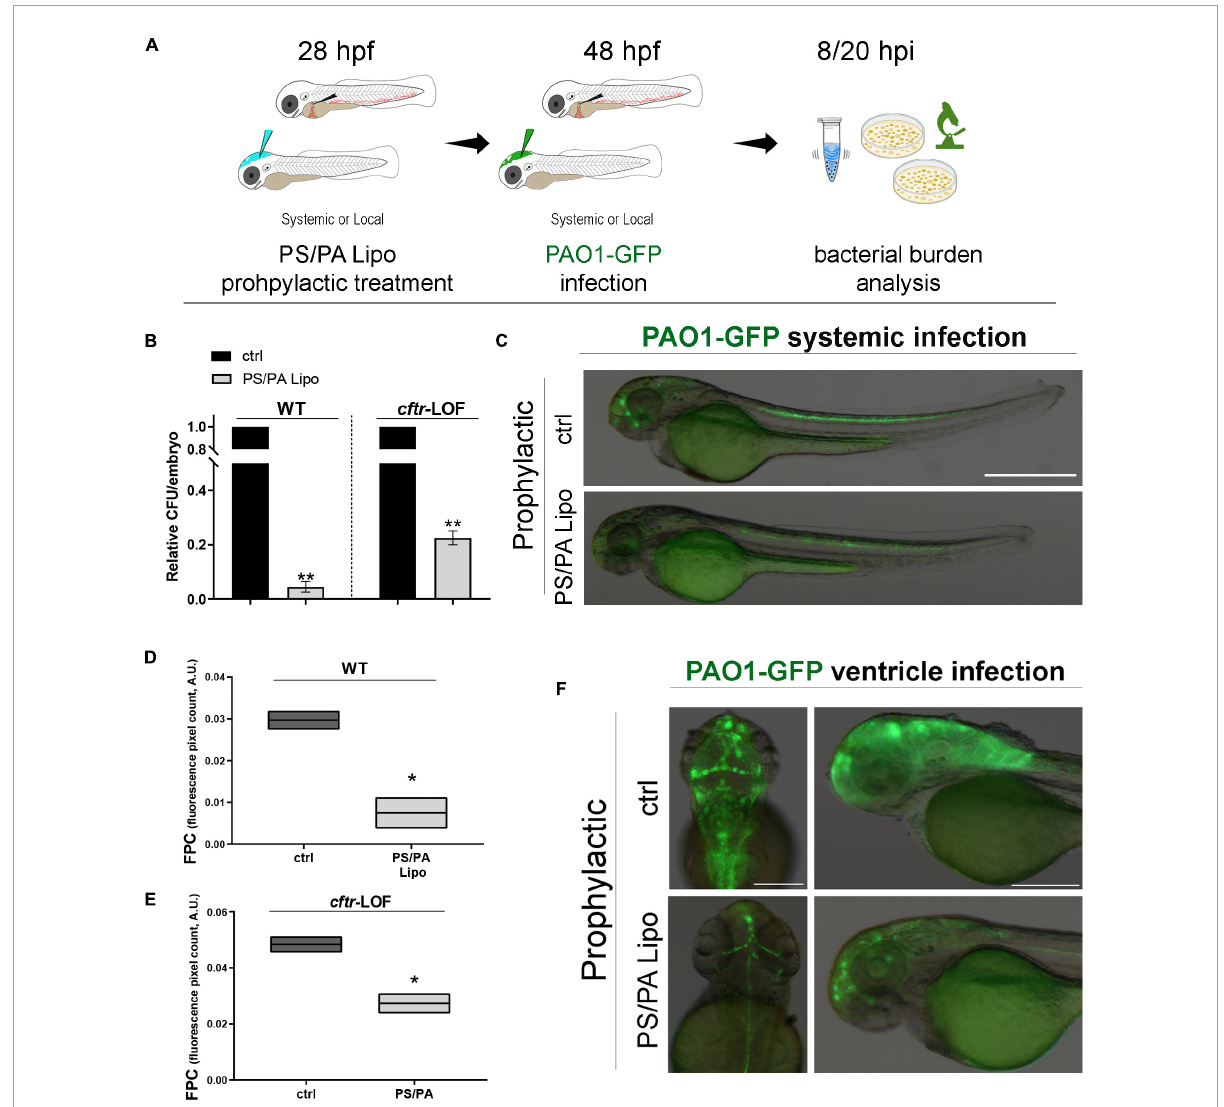
FIGURE1 Antimicrobial activity of phosphatidylserine/phosphatidic acid (PS/PA) liposome prophylactic administration in wild-type (WT) and cftr -LOF zebrafish embryos. (A) Schematic representation of PS/PA liposome prophylactic treatment. Zebrafish embryos were treated with PS/PA liposome at 28 hpf, then systemically or locally infected with 100–300 CFU PAO1-GFP at 48 hpf and analyzed for bacterial burden at 8 or 20 h post infection. (B) Bacterial load (relative CFU/embryo) in systemically infected WT and cftr -LOF embryos, control (ctrl), and PS/PA liposome treated at 8 hpi. Results are presented as mean ± SEM. (C) Representative images of PAO1-GFP systemic bacterial infection in ctrl and PS/PA liposome treated embryos. (D,E) Quantitative analysis (fluorescence pixel count) of PAO1-GFP locally injected in the close cavity of the hindbrain ventricle of WT and cftr -LOF embryos, control (ctrl) and PS/PA liposome treated. The mean and the min to max values of at least two independent experiments (3–10 embryos/treatment) were reported on floating bars. (F) Representative images of PAO1-GFP ventricle bacterial infection in ctrl and PS/PA liposome treated embryos. Statistical significance was assessed by unpaired Student’s t test: ** p < 0.01; * p < 0.05. Scale bar indicates 500 µ m in panel (C) and 200 µ m (dorsal) and 150 µ m (lateral) in panel (F)